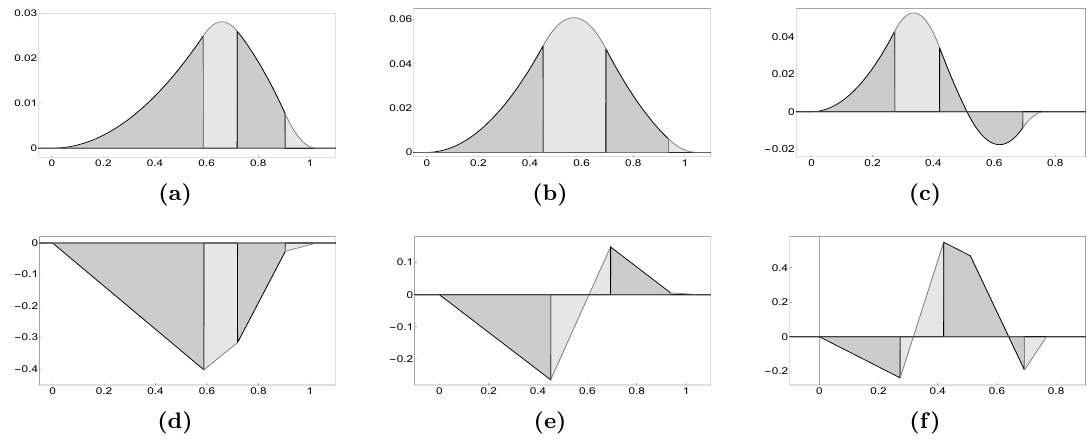
Figure 4 . The generalized exact oscillon with the velocity u = + V in the laboratory reference frame at t = 0. The oscillon is parametrized by v = 0 : 3. Figures (a), (b), (c) show the initial shape of the